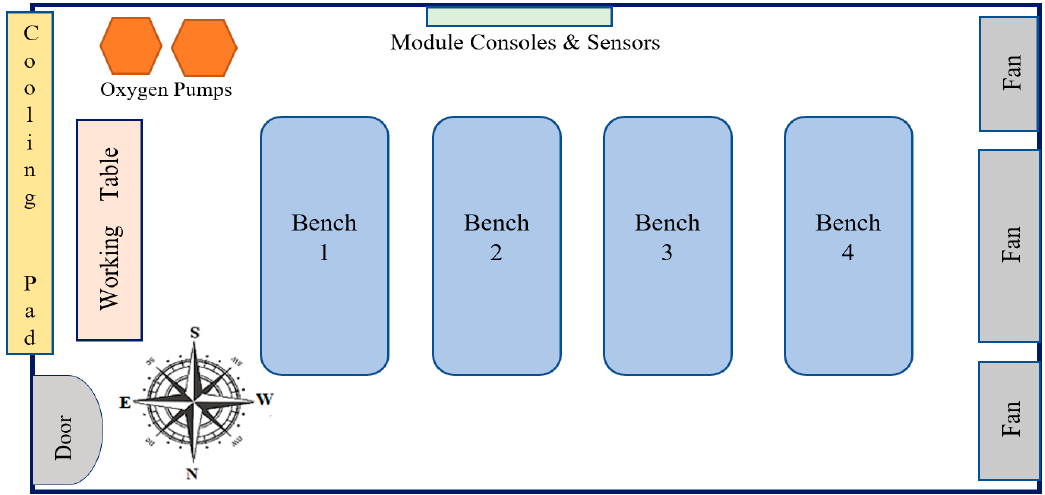
Figure 1. Top view of the indoor layout of the experimental greenhouse room.